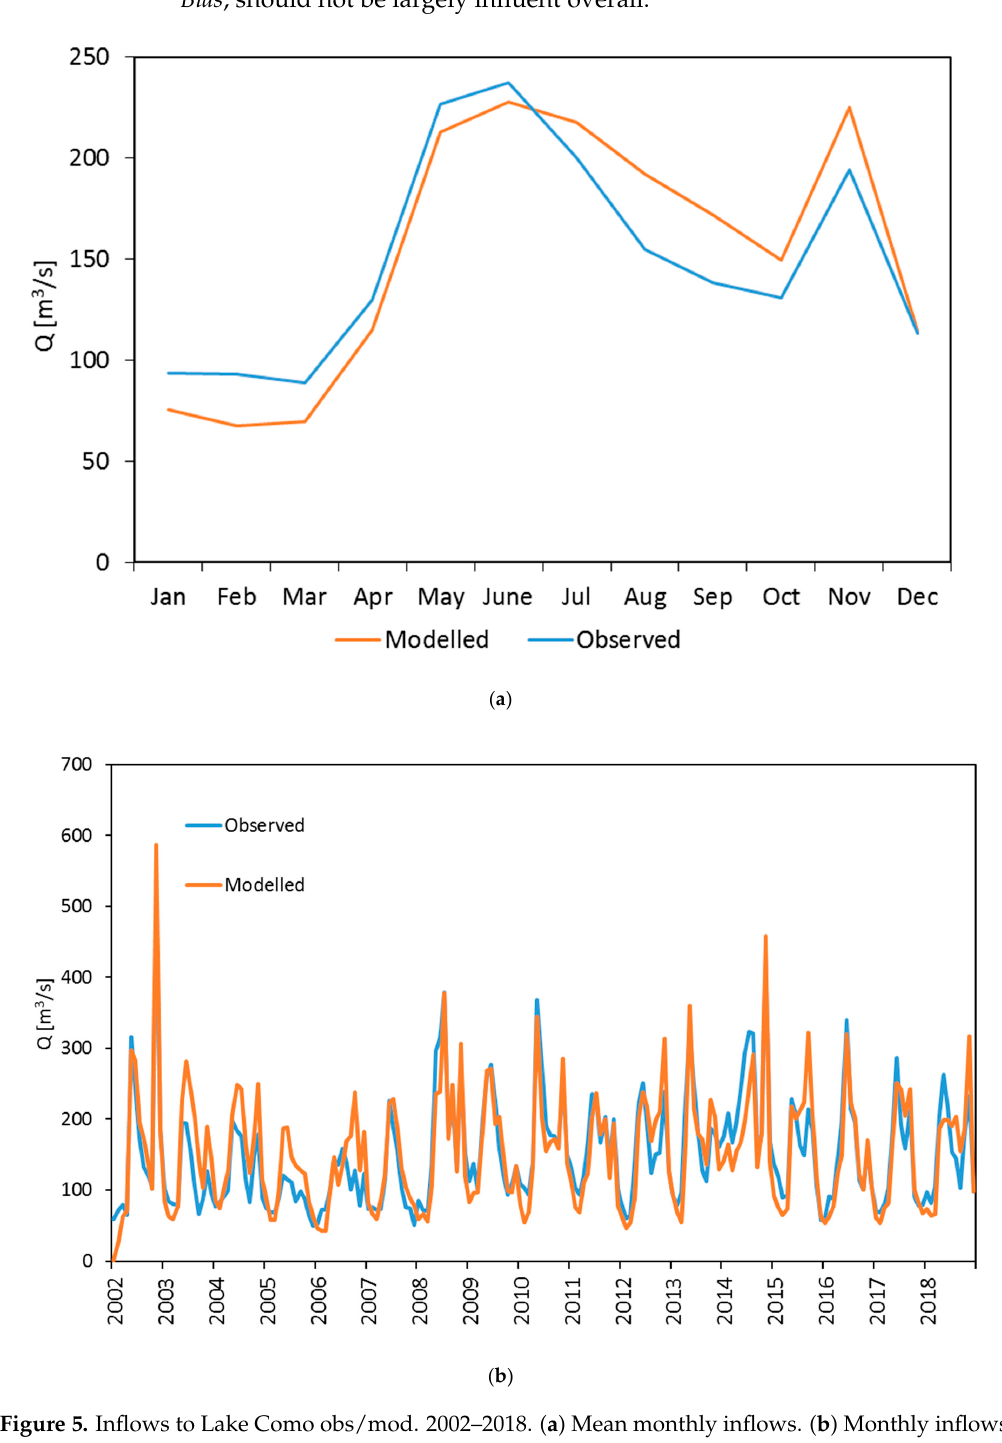
Figure 5. Inflows to Lake Como obs/mod. 2002–2018. ( a ) Mean monthly inflows. ( b ) Monthly inflows.